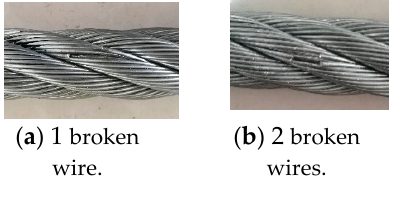
Figure 15. Broken wire damage.